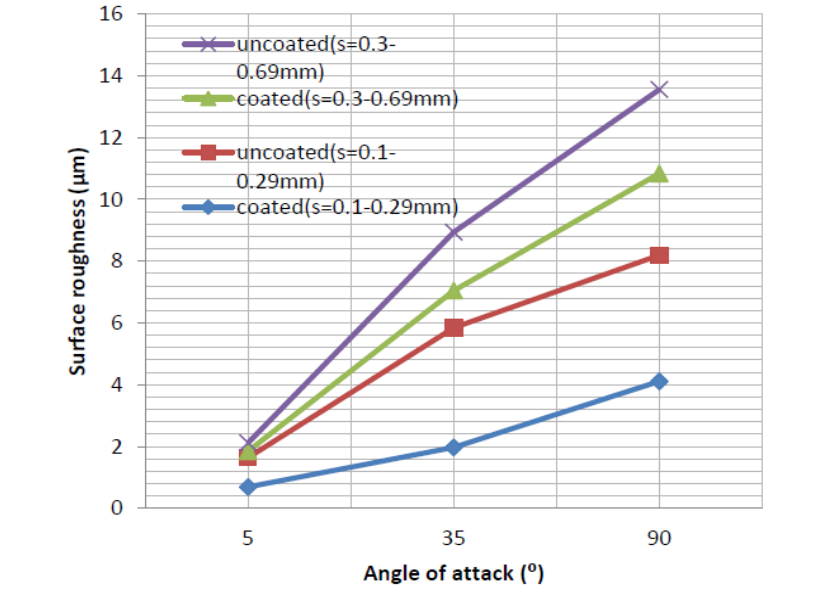
Figure 14: Experimental results of surface roughness vs. angle of attacks for different coated and uncoated